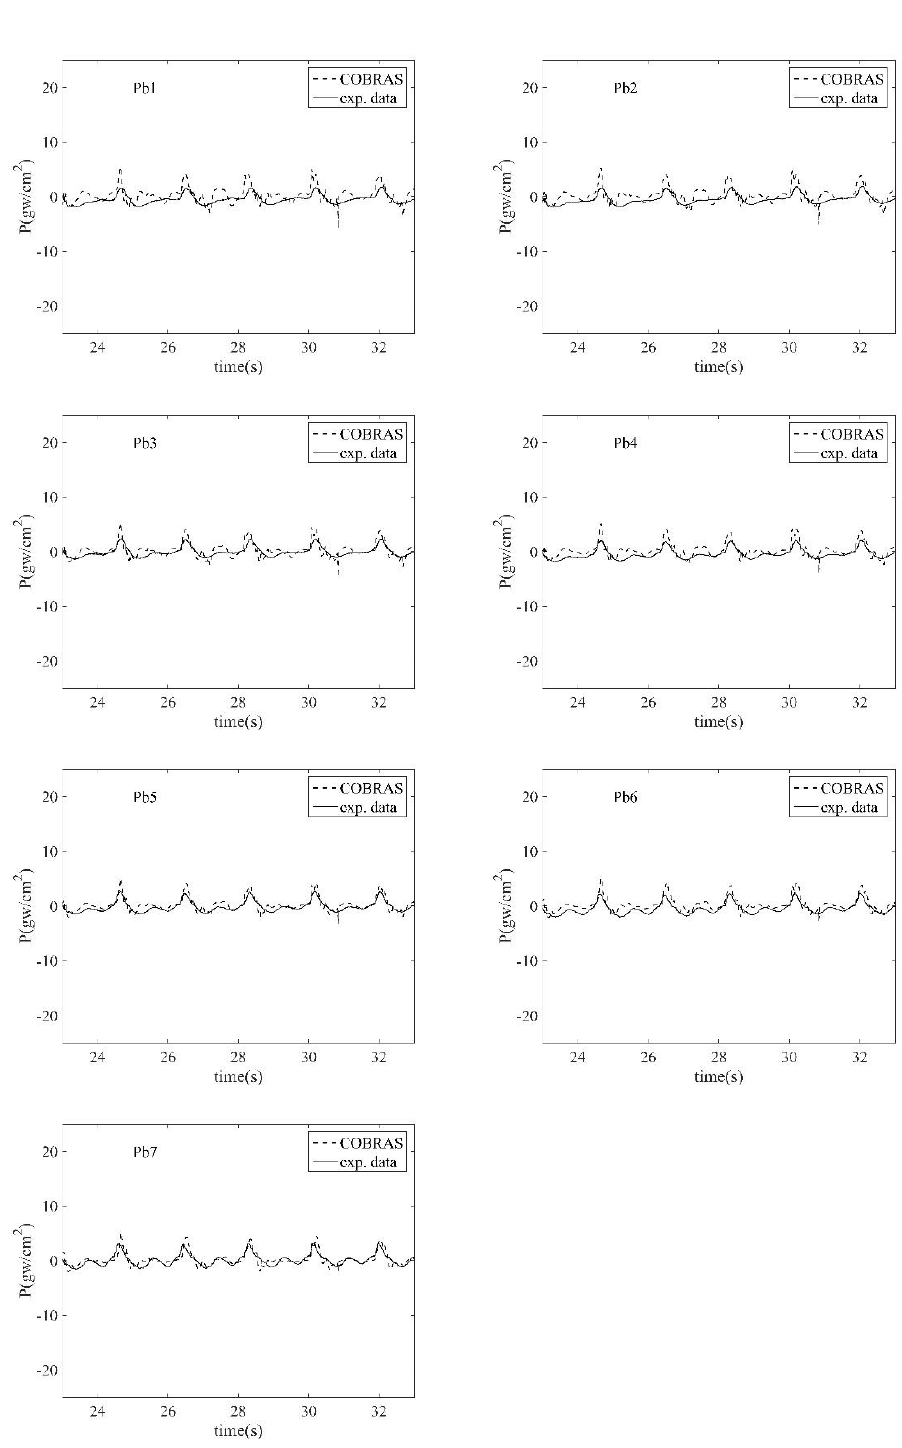
Figure 5. The comparison between numerical model and laboratory measurement for the time series of dynamic wave pressure on the seaward face.